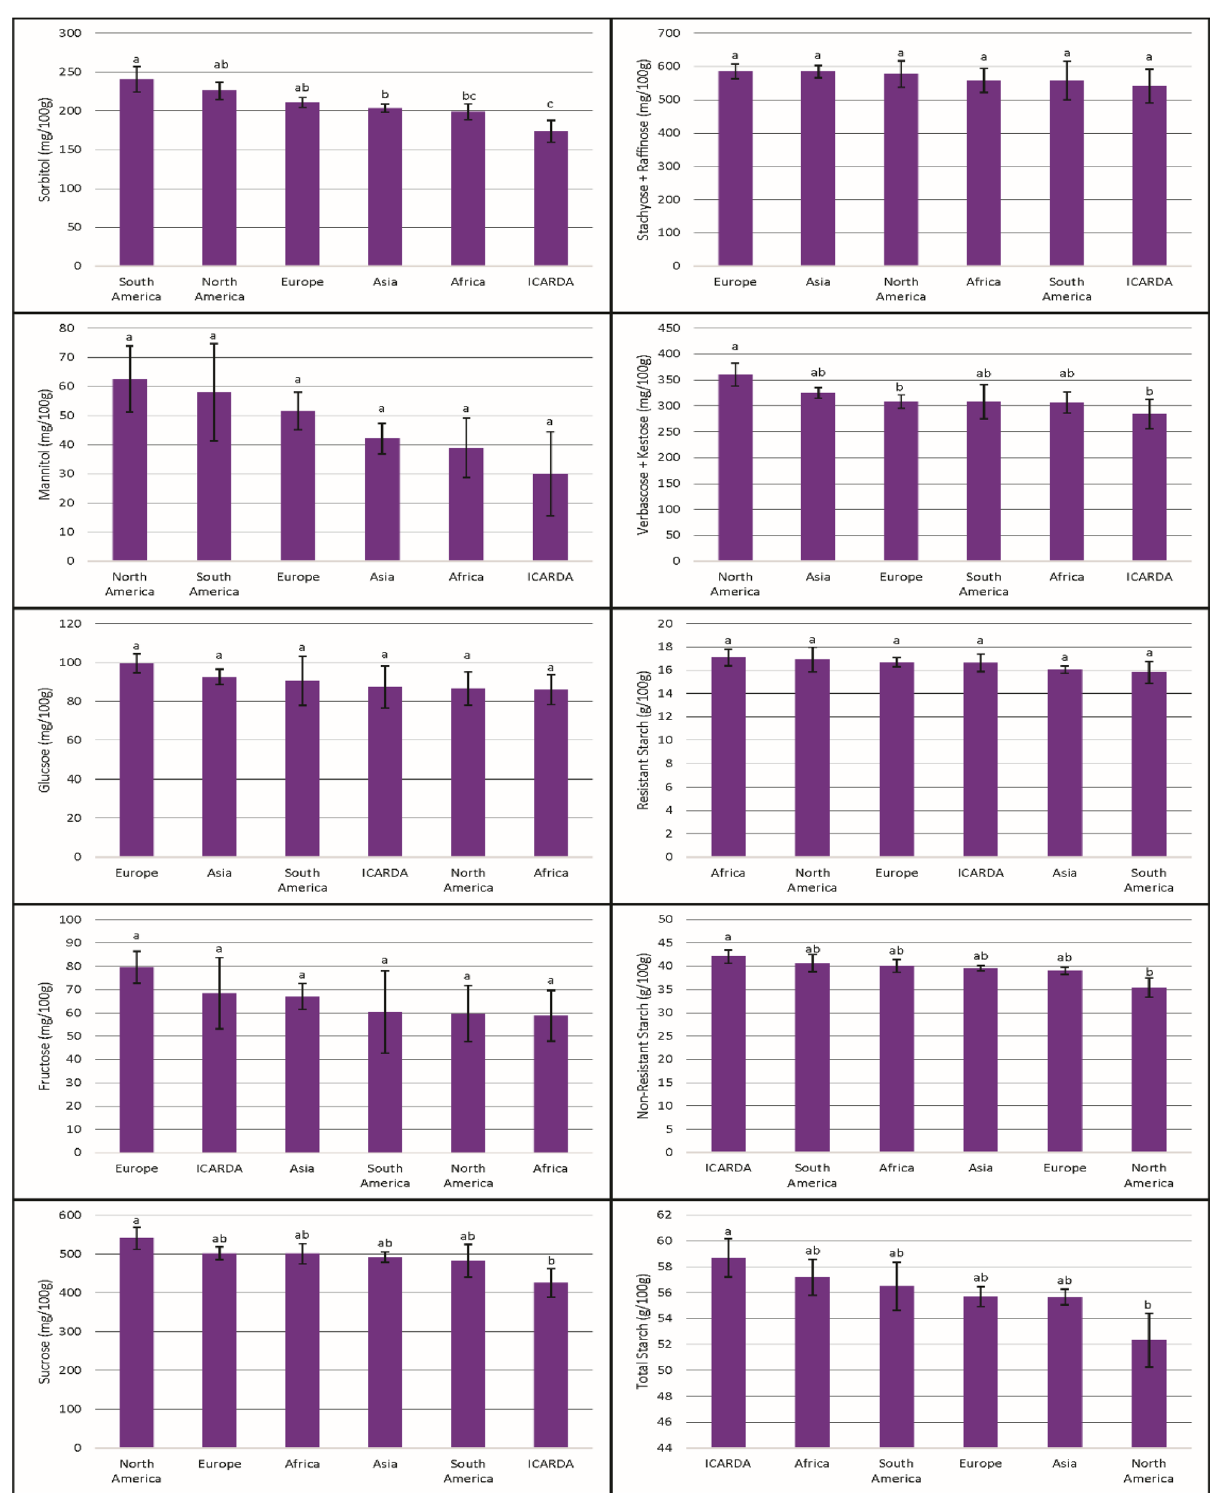
Figure 2. Comparison of carbohydrate concentrations by continent of origin. Bars separated by different letters have significantly different means (p < 0.05). Bars labeled as ICARDA originated as part of the ICARDA breeding